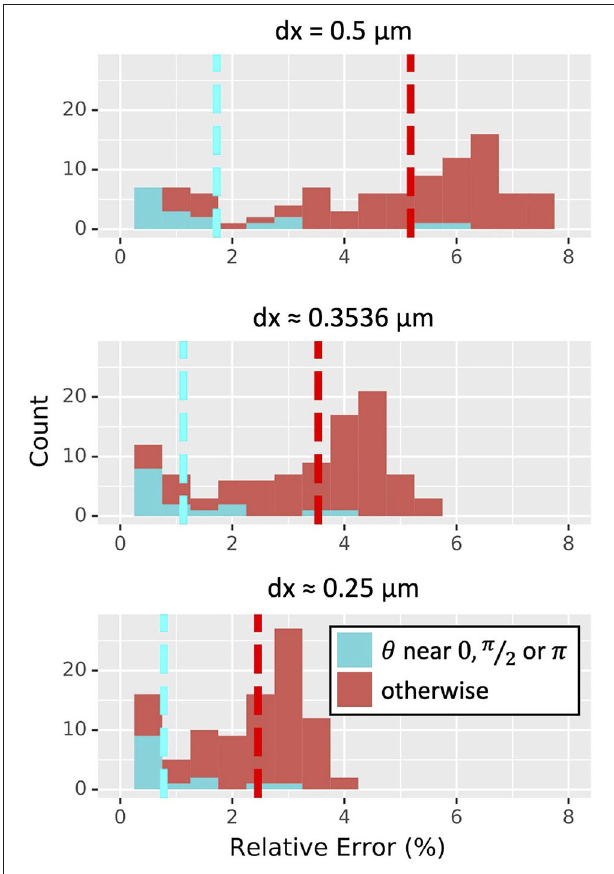
FIGURE 8 | Distribution of relative error in wave speed for the scalar bistable wave with α 0.25 derived from 100 random orientations of a 251 µ m long, 2 = µ m diameter cylinder simulated in 3D at three choices of dx (measured in µ m); all graphs are on the same scale. Simulations with θ within 0.1 radians of 0, π/ 2, or π corresponding to cylinders nearly parallel to either the x , y plane or the z axis are in cyan and tended to have lower errors than those that were oriented otherwise. Dashed lines indicate mean